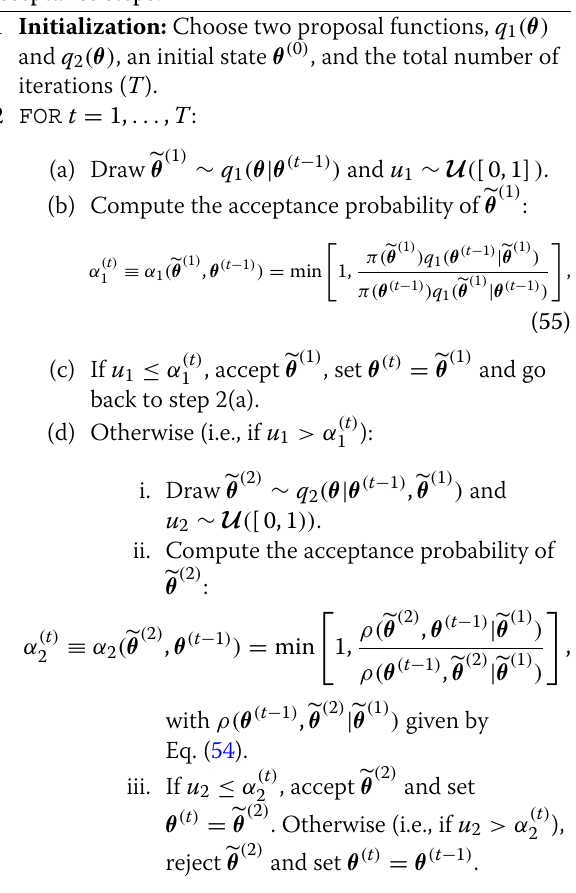
Algorithm 17 Delayed Rejection Metropolis with two acceptance